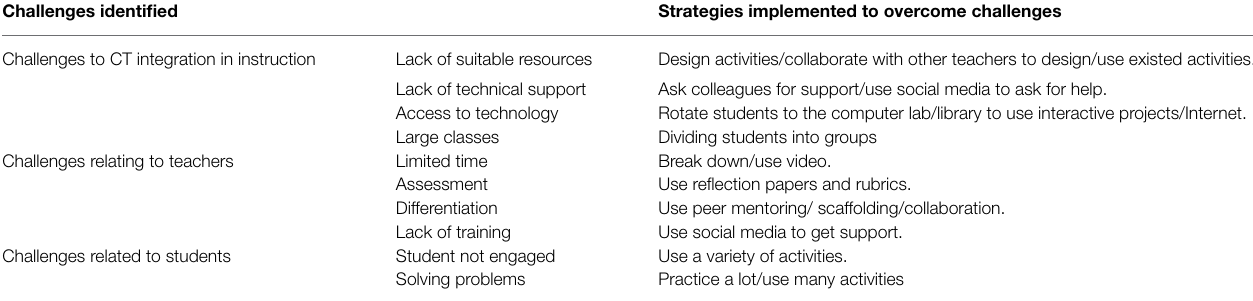
TABLE 4 | Challenges and strategies in adoption of